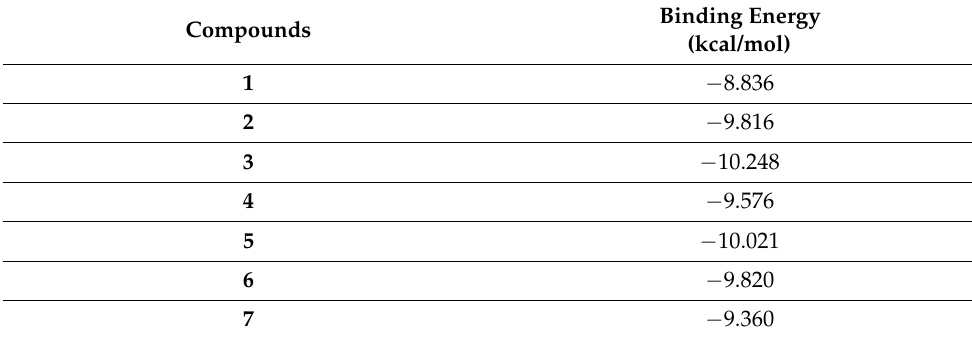
Table 1. Binding energy of dioxocins 1–7 docked with